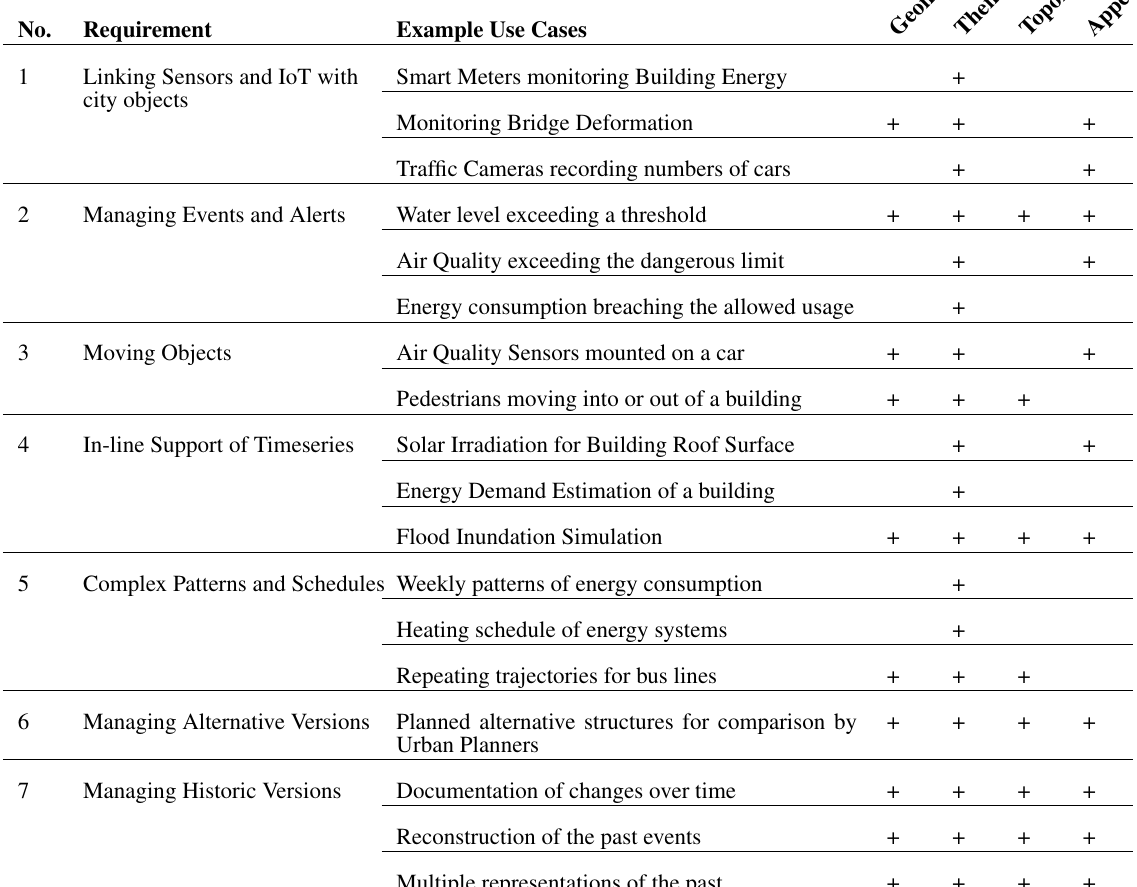
Table 1. Based on the application domains, list of key requirements recommended to be considered for extending Semantic 3D City Model for supporting time-dependent